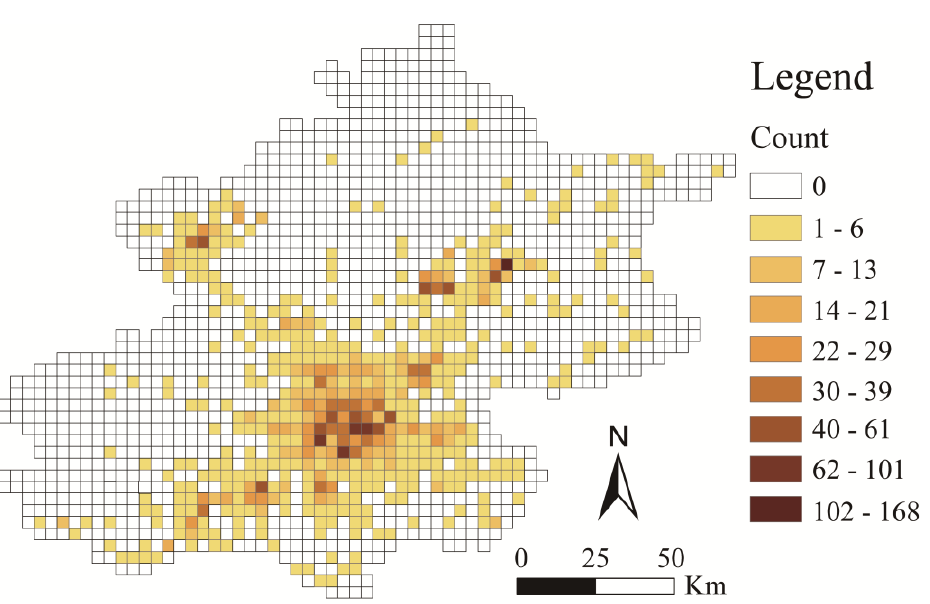
Table 1. Accuracy and efficiency of particle grids at different levels for GeoSOT and the GEA model. Level of Particle Grid